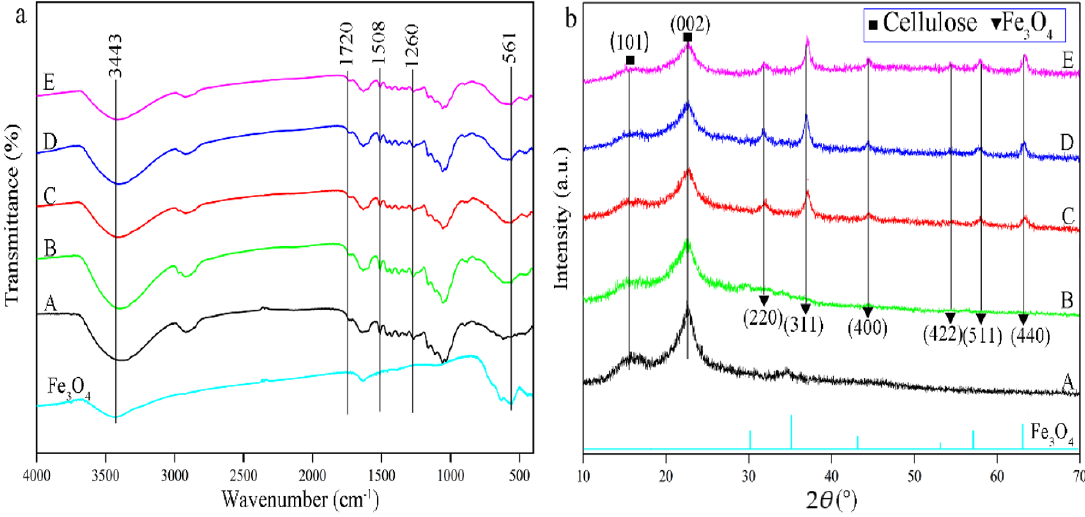
Figure 3. Fourier transform infrared spectroscopy (FTIR) spectra ( a ) and X-ray diffraction (XRD) patterns ( b ) of fiber pulp, nano-Fe 3 O 4 and NFF composite pulp. (A. treated fiber; B. NFF1; C. NFF2;